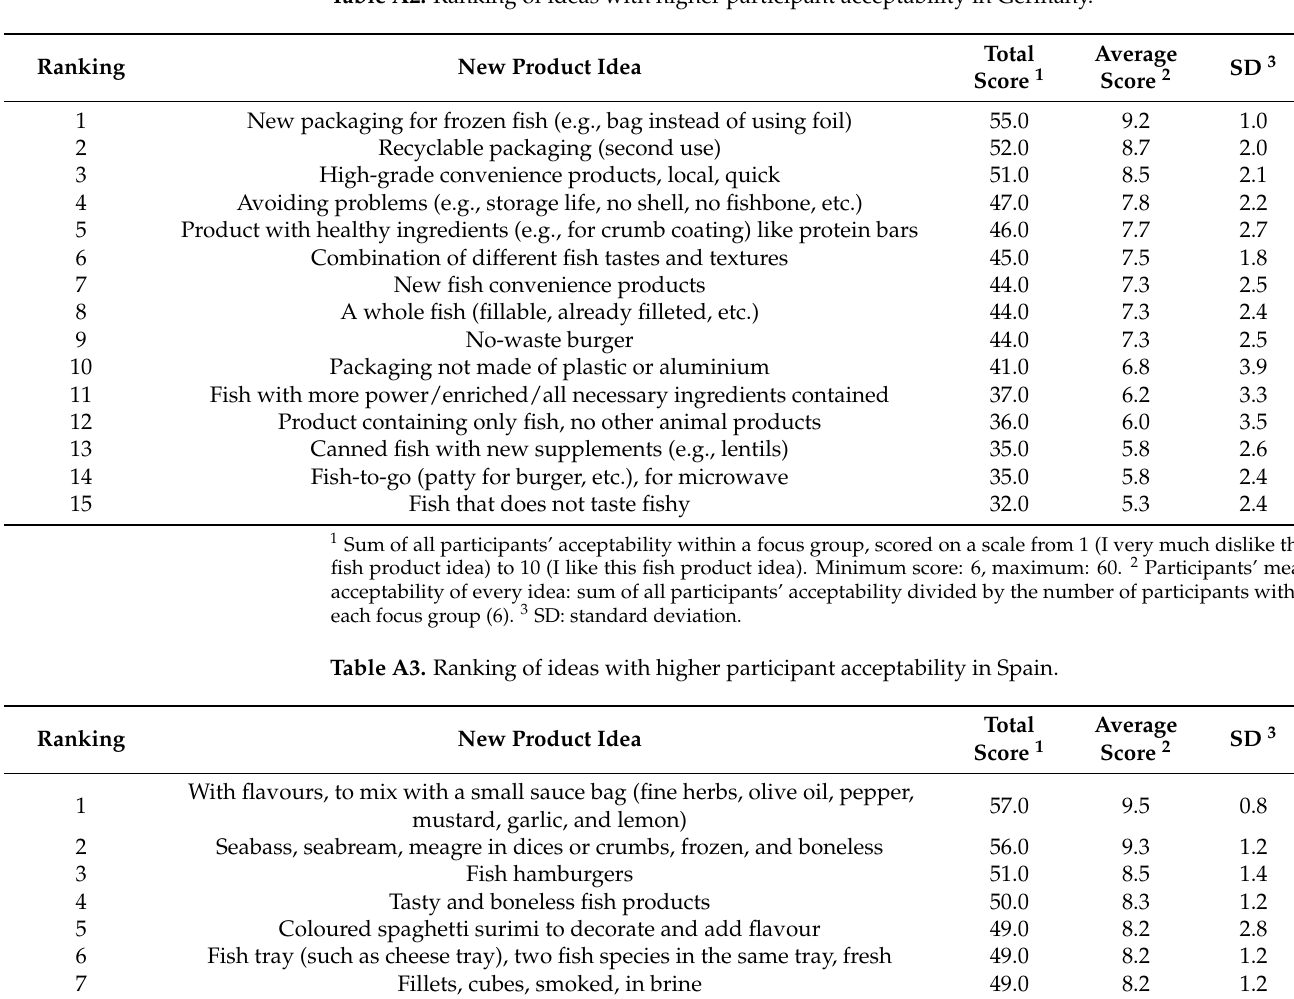
Table A2. Ranking of ideas with higher participant acceptability in Germany.